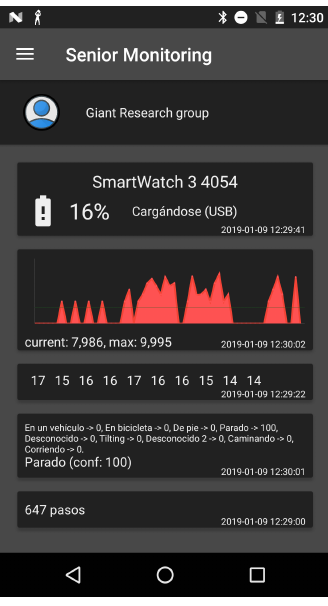
Figure 3. The application main screen shows detailed information about the smartwatch status, the levels of physical activity of the user in the previous hour, and other useful information from other active sensors such as Wi-Fi access points detected or a daily step